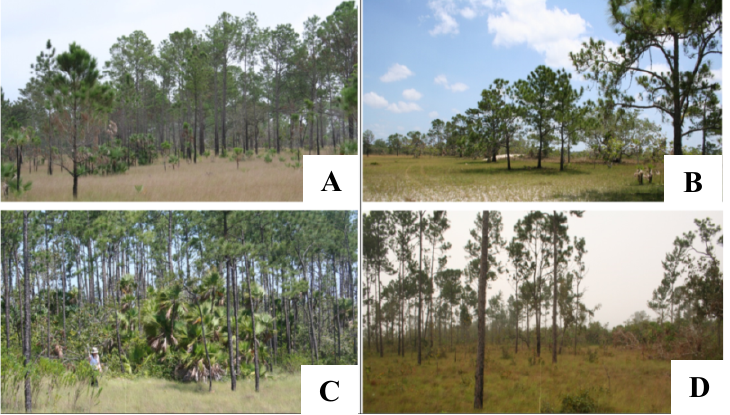
Figure 2. Representative photographs of lowland savanna areas with dense trees or